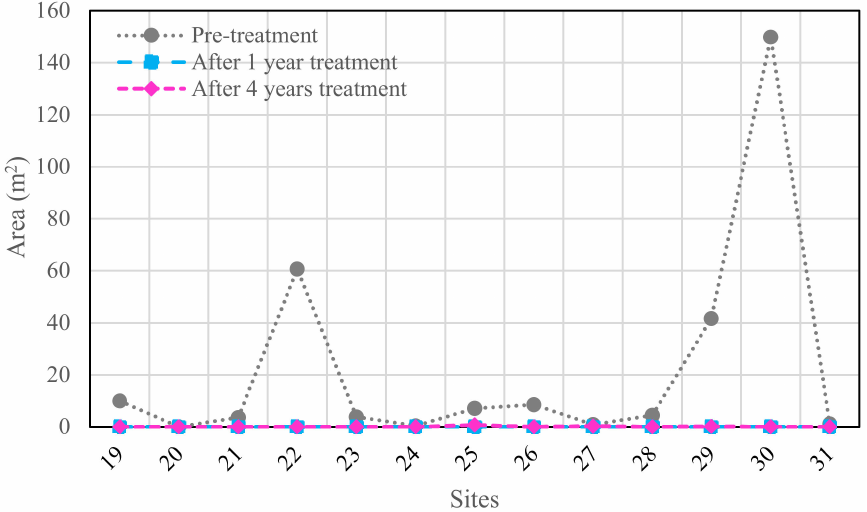
Figure 11. Effectiveness of WMA overlay containing RAP on alligator cracking under wet climatic